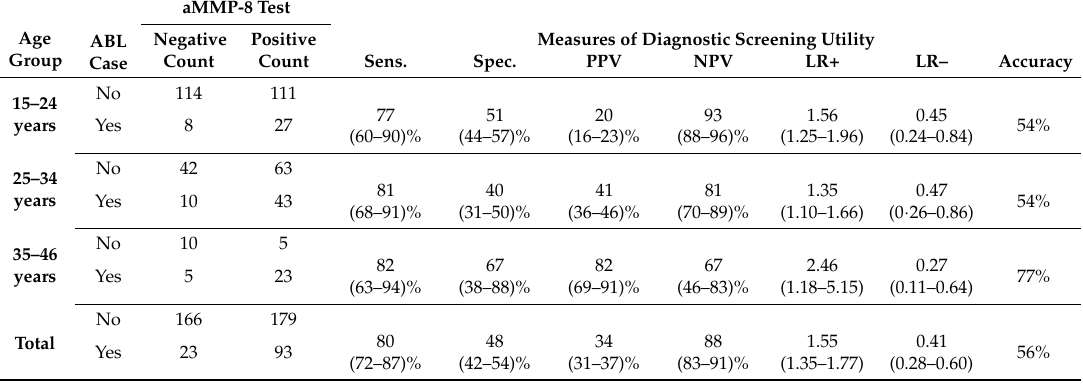
Table 5. Cross tabulation of aMMP-8 test results and the dichotomous ABL-case